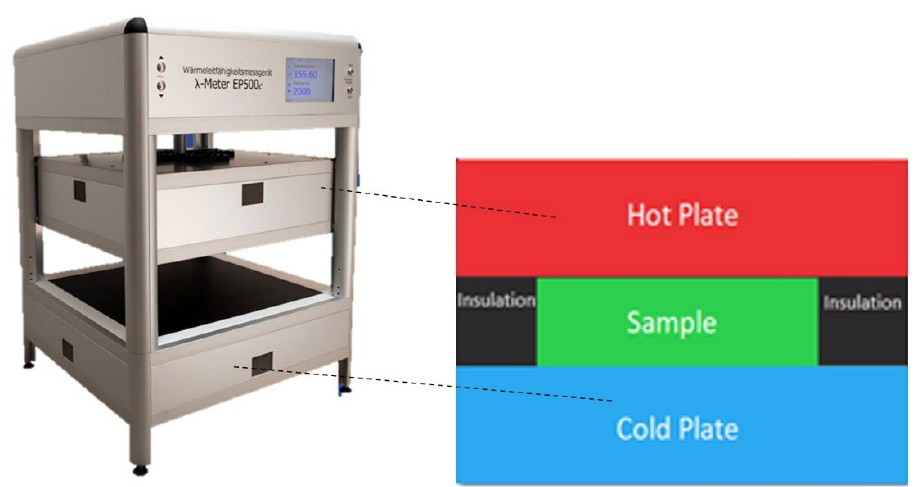
Figure 1. Picture and scheme of the Lambda-meter EP500e.